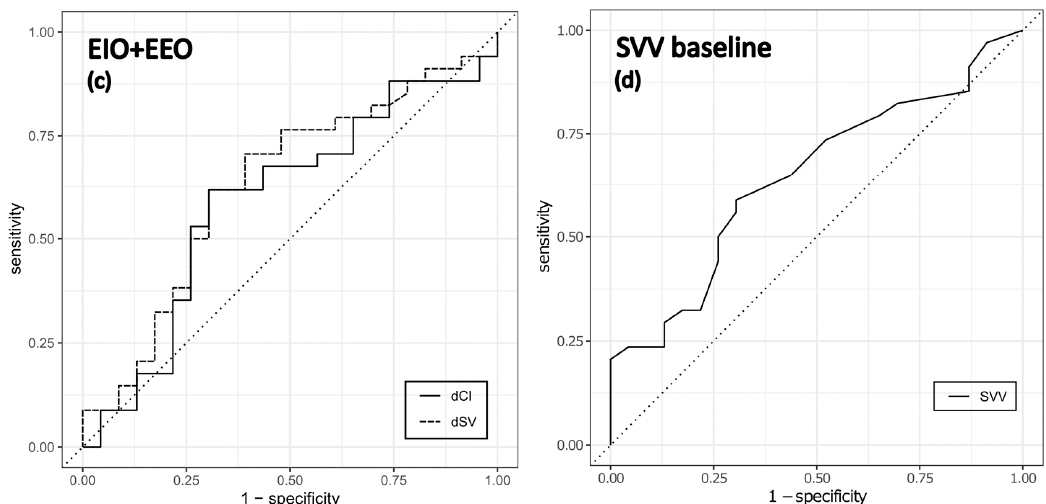
Figure 3. Receiver operating characteristic (ROC) curves evaluating the ability of changes in CI and SV to predict fluid responsiveness during ( a ) EIO, ( b ) EEO and ( c ) combined EIO and EEO maneuvers; ( d ) shows the ROC curve of fluid responsiveness prediction based on baseline SVV.